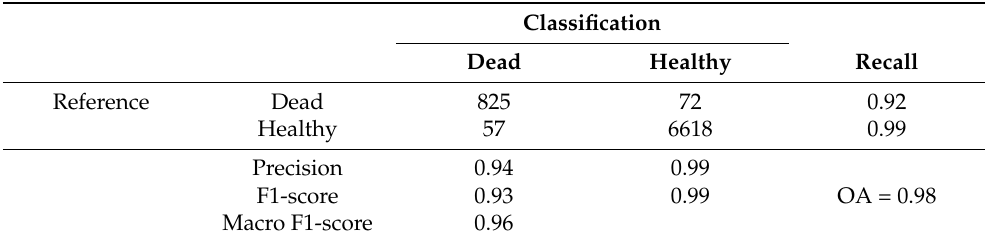
Table 2. Confusion matrix for the result of the k-means classifier using the three vegetation indices. Columns represent the classification results and rows represent the reference